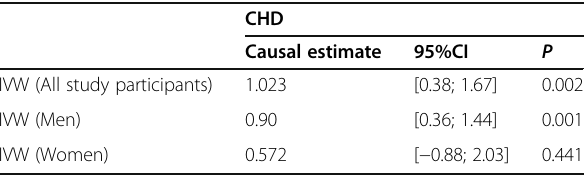
Table 3 Causal estimates of the presence of coronary artery calcification on coronary heart disease from Mendelian Randomization